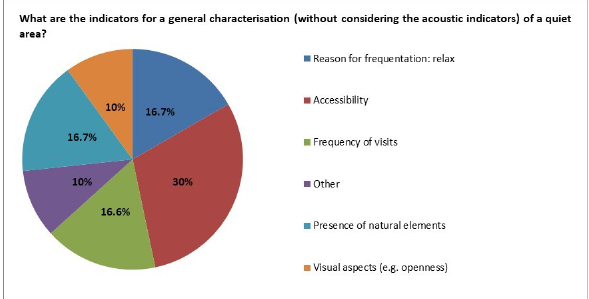
Figure 1: Answers to the stakeholders’ question about general (not acoustic) indicators for quiet areas.